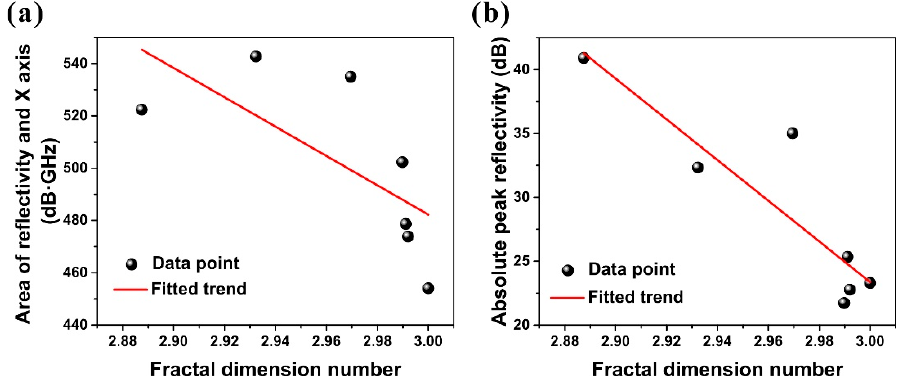
Figure 5. Quantitative correlation and fitted trends between the fractal dimension number of proposed structure and ( a ) area surrounded by reflectivity curve and X -axis, ( b ) peak value of reflectivity curve.